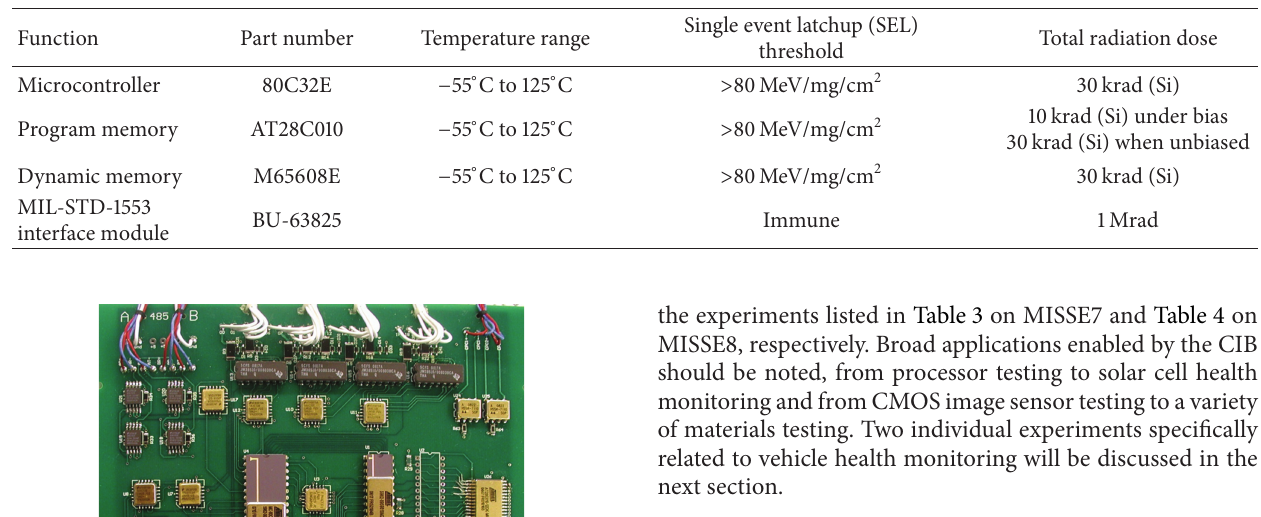
Table 2: CIB core system components and respective environmental operating specifications.